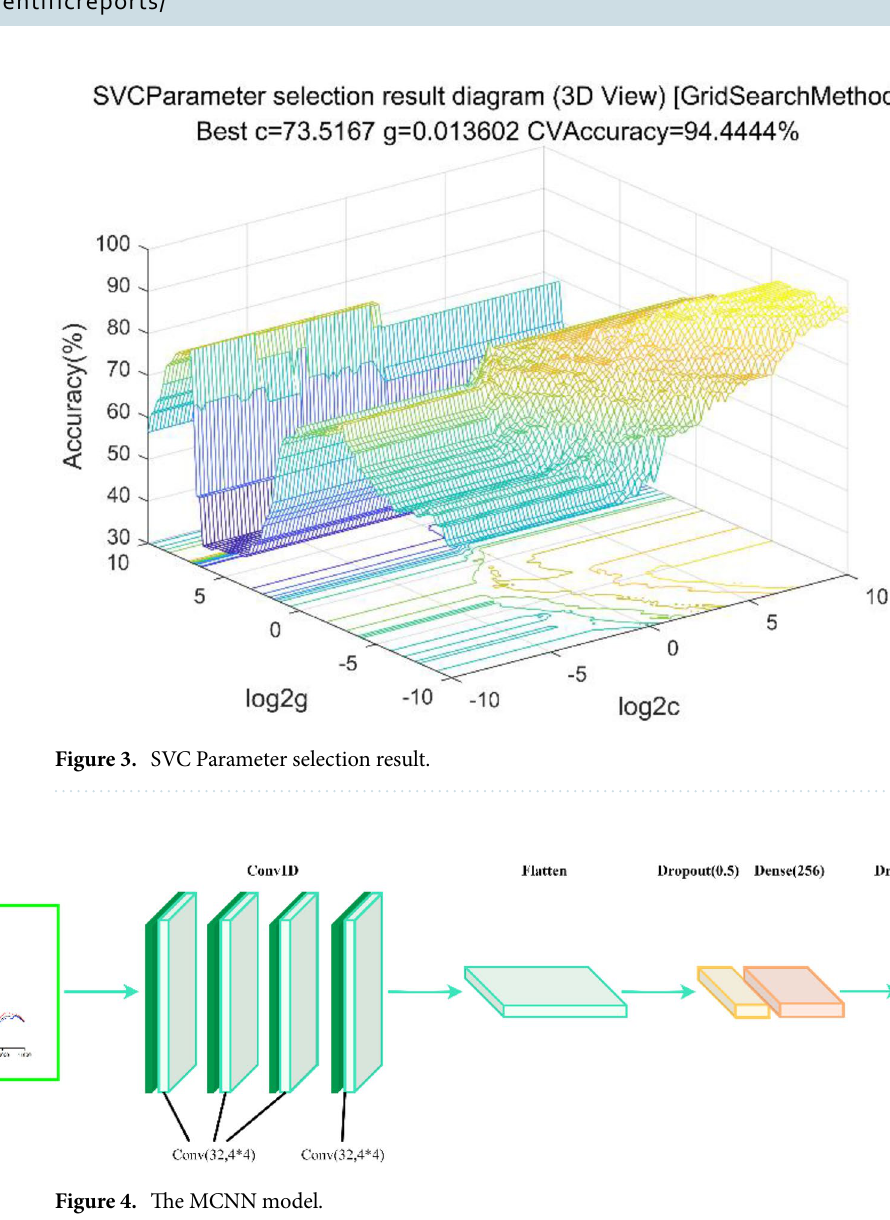
Figure 4. The MCNN model.